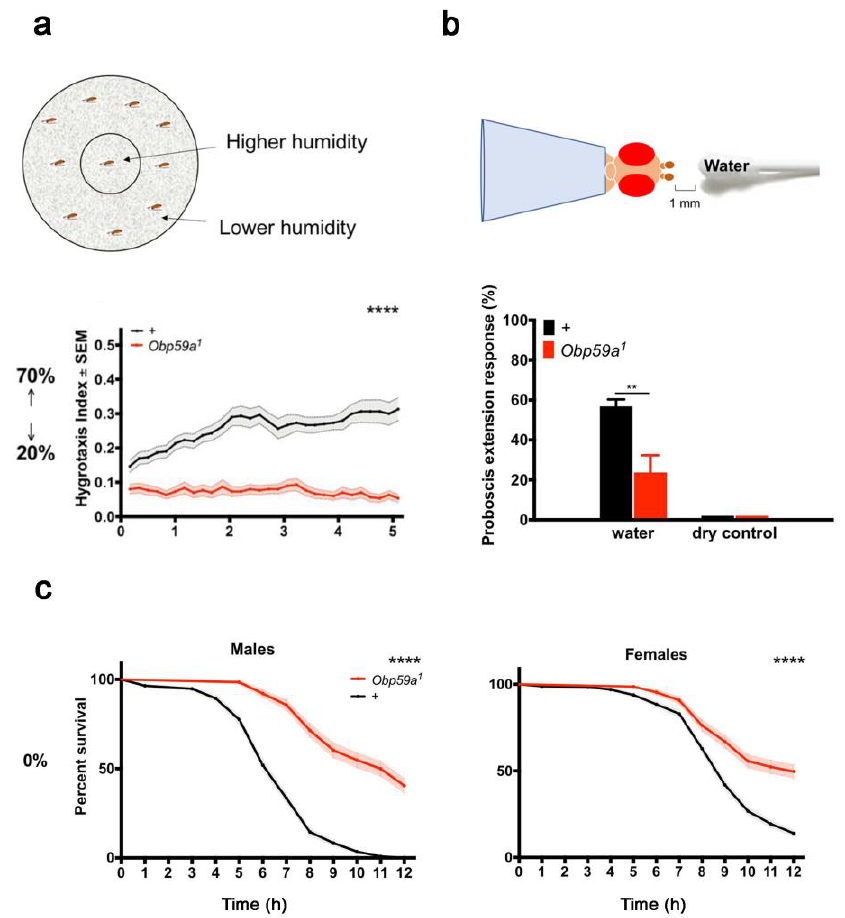
Figure 9. OBP59a is necessary for the detection of humidity and desiccation resistance. ( a ) Top: schematic representation of the hygrotaxis paradigm in a Petri dish. Bottom: Hygrotaxis responses of control (black) and OBP59a-deficient mutant (red) flies presented a choice between 20% and 70% humidity. **** p < 0.0001; Friedman test with Dunn’s multiple comparisons test. ( b ) Top: Illustration of the proboscis extension response paradigm (PER). Bottom: PER responses of control and OBP59a mutant flies to water vapor. ** p < 0.01; Mann-Whitney test. ( c ) Accumulated survival rate of control (black) and OBP59a mutant (red) male and female flies placed under desiccating conditions. **** p < 0.0001, log-rank (Mantel-Cox) test. Adapted from [57].